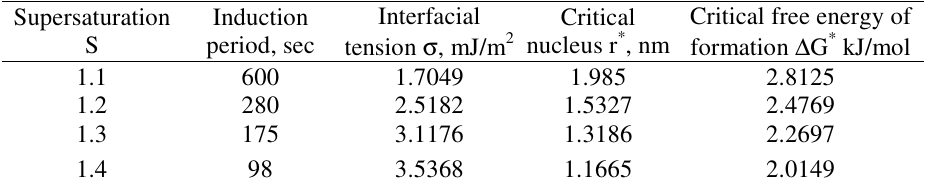
Table 1. Experimentally determined values of induction period, interfacial tension, critical nucleus and critical free energy of formation of zinc sulphate hepta hydrate